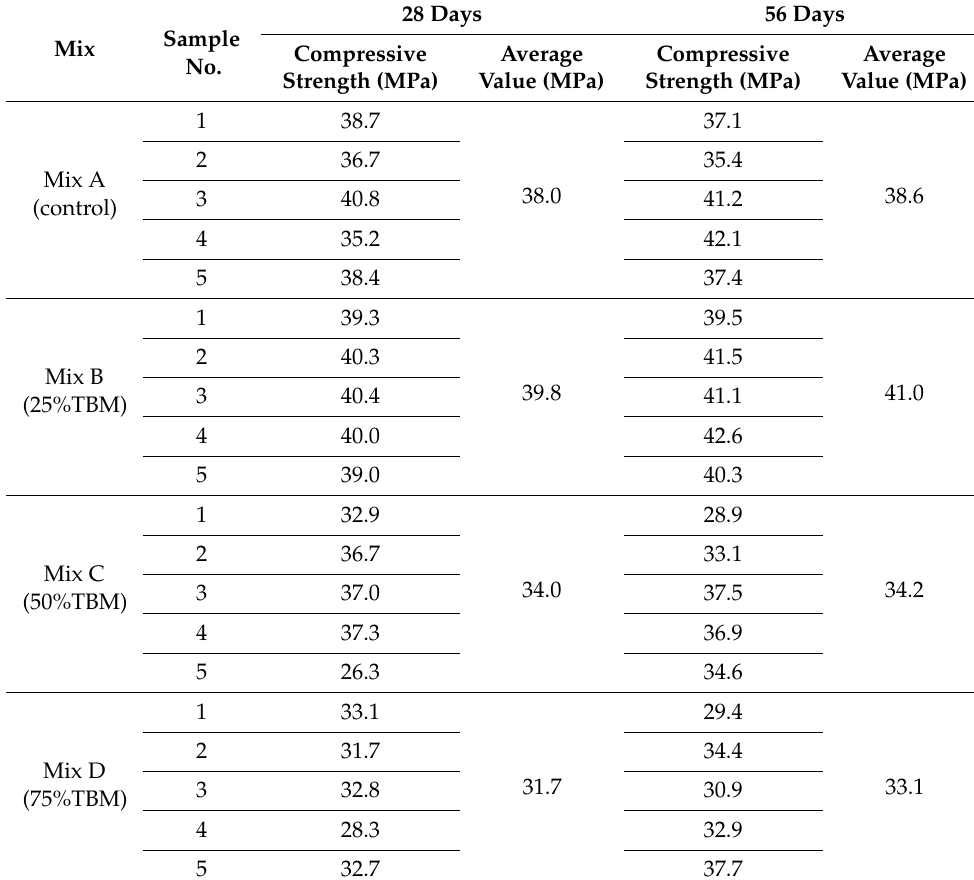
Table 4. Compressive strength values of all mixes at 28 and 56